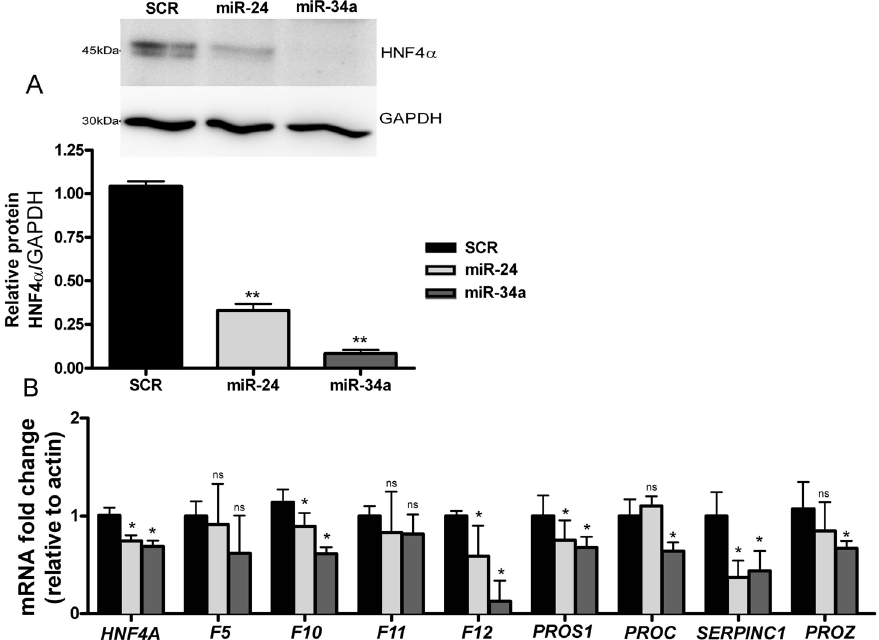
Fig 4. Effect of miRNAs on HNF4A and coagulation factors expression in HepG2. HepG2 cells were transfected with 100 nM mimic precursors of miR-24, miR-34a or SCR. Protein lysates and total RNA were obtained after 48 h incubation and analyzed. A) Densitometric analysis of HNF4 α protein expression transfected with SCR, miR-24, and miR-34a; representative western blot. B)qRT-PCR analysis of HNF4A and coagulation factors mRNA expression. The asterisk indicates a statistically significant difference (P < 0.05) and “ ns ” indicates a statistically non-significant difference (P > 0.05). Results are mean ± SD of three independent experiments performed in